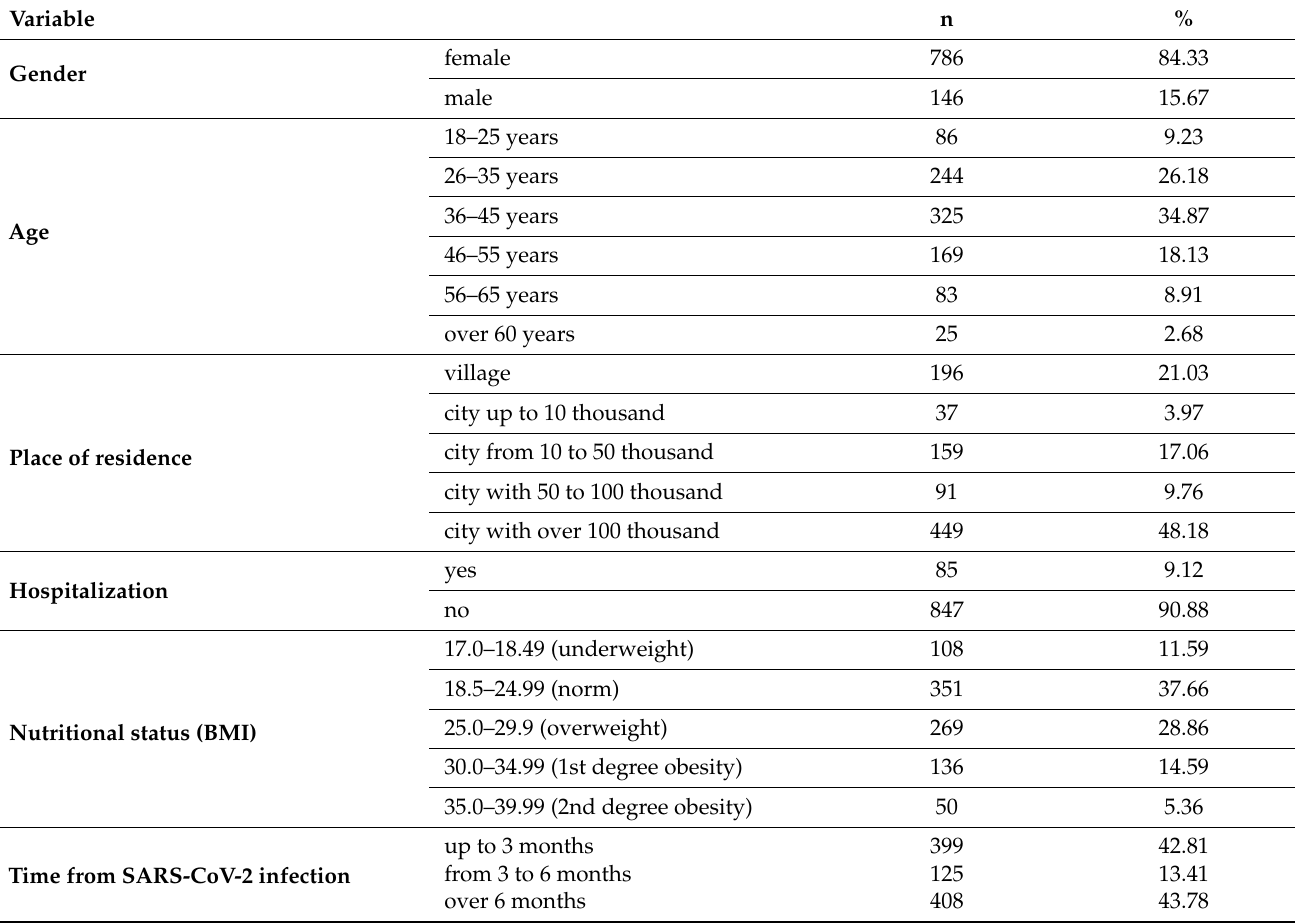
Table 1. Characteristics of the study